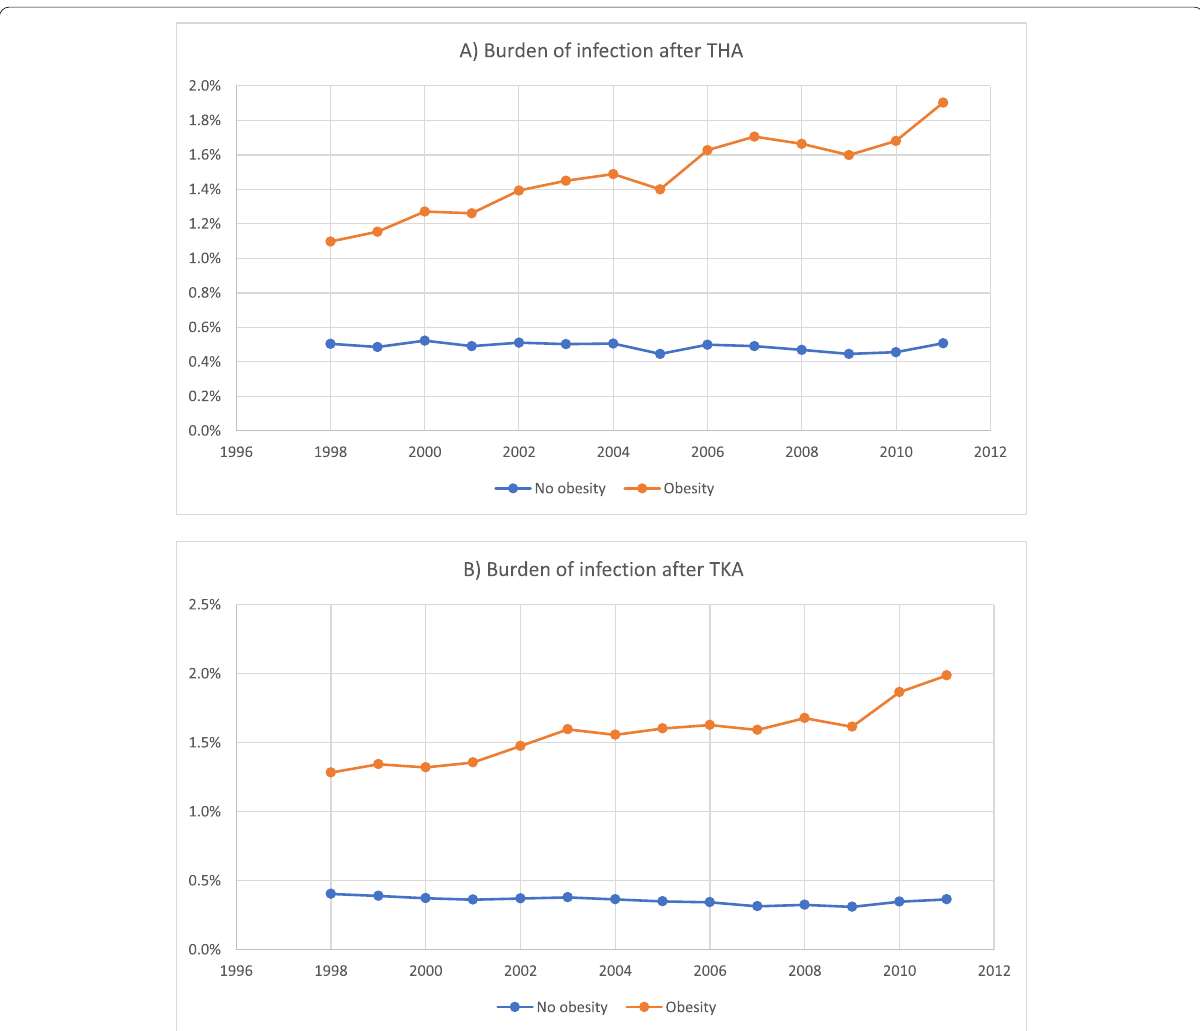
Fig. 1 Increased infection burden (infected procedures/total procedures) in patients with obesity after (A) total hip arthroplasty (THA) and (B) total knee arthroplasty (TKA) from 1998 to 2011 in the United States. Recreated from George et al.